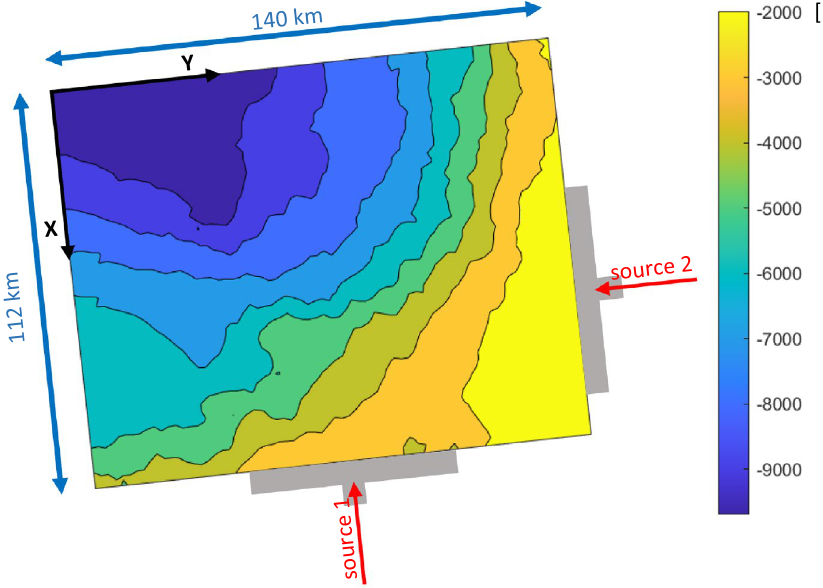
Figure 3. Planar geometry, bathymetry map at 146 Ma and location of the two sediment supply